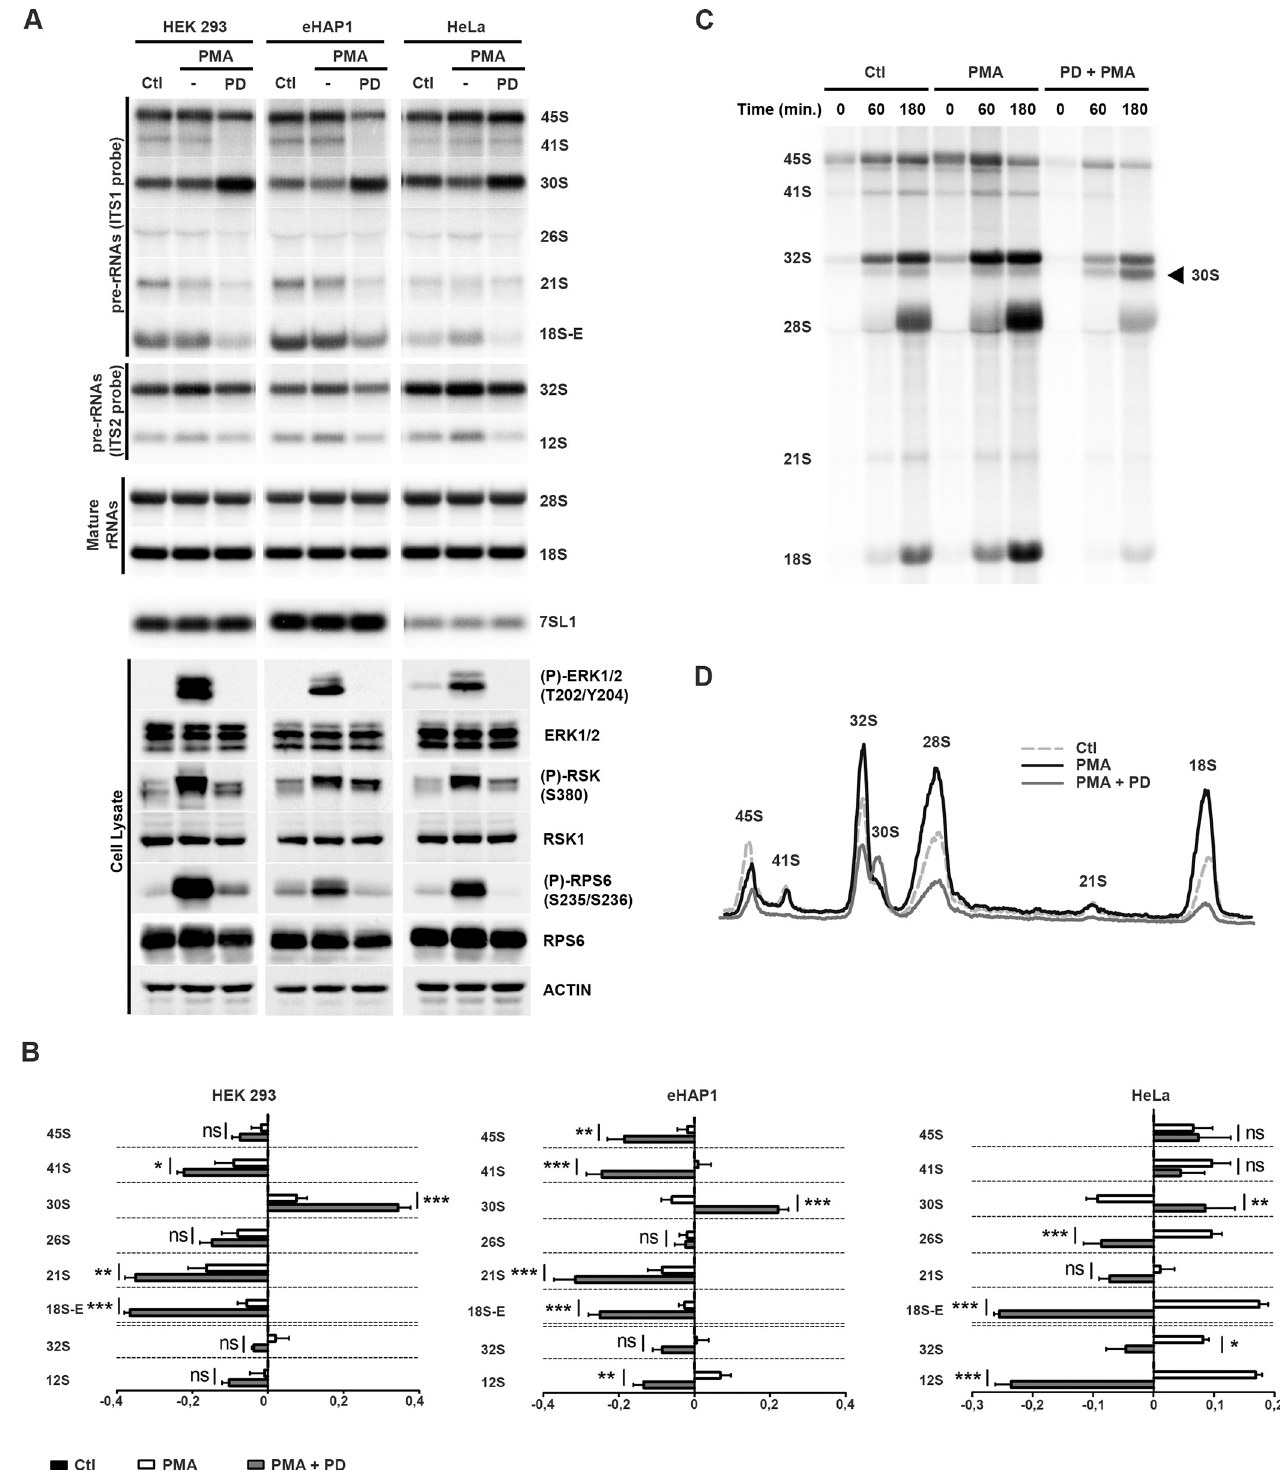
Fig 1. The MAPK signaling pathway regulates post-transcriptional stages of ribosome biogenesis. (A) Serum-starved HEK293, eHAP1 or HeLa cells were stimulated (PMA) or not (Ctl) with PMA (100 ng/ml) for 30 min, then treated (PD) or not (-) with 10 μ M of PD184352 for 3h. Total RNAs were extracted and the levels of precursor and mature rRNAs and 7SL1 RNA were monitored by Northern blotting (NB, see S1A Fig for a detailed representation of the human pre-rRNA processing pathway and position of the probes). Total proteins were extracted and analyzed by Western blotting (WB) using the indicated